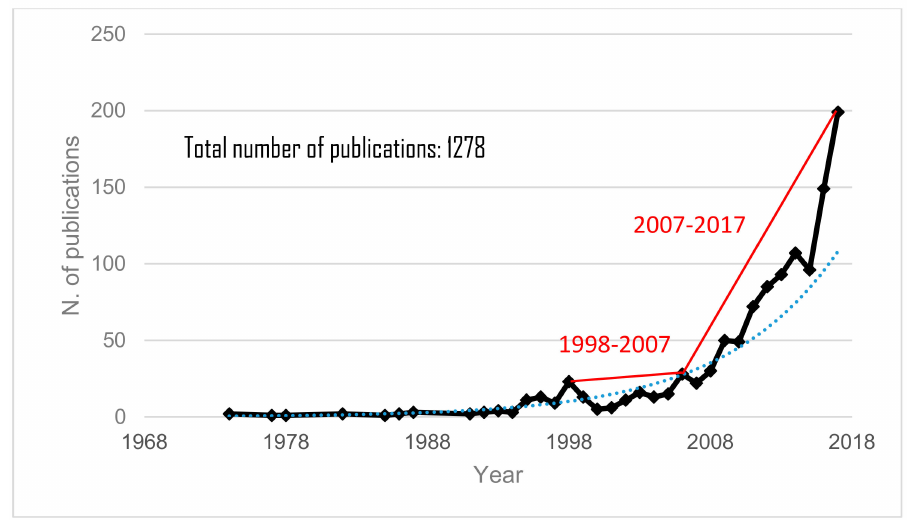
Figure 2. Number of publications per year on the use of crumb rubber in engineering